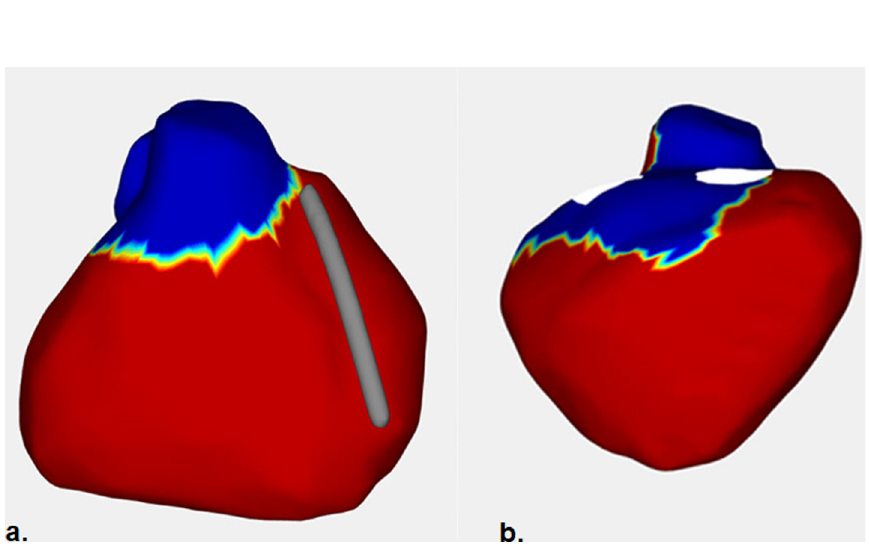
Fig 1. Example of the pattern of terminal ventricular activation in a control subject. The figure presents the area activated during the last 20 msec of the total ventricular epicardial activation (noted with blue color) in a control. Note that the activation during the last 20msec involves the RVOT (a) and parts of LV and RV base (b). a = RV anterior wall, b = RV inferior wall. ARVC = Arrhythmogenic Right Ventricular Cardiomyopathy, RVOT = right ventricular outflow tract, RV = right ventricle, LV = left